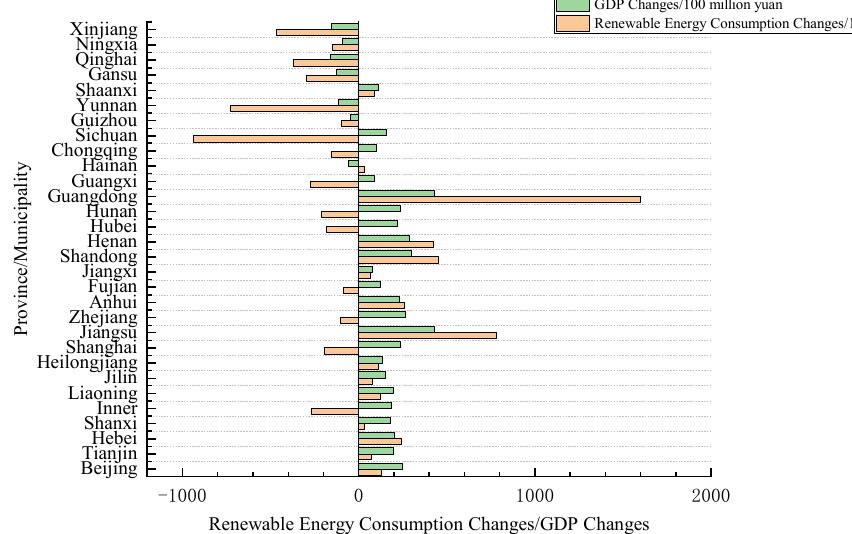
Figure 4. RPS Allocation Efficiency and Adjustment Results for the RPS.